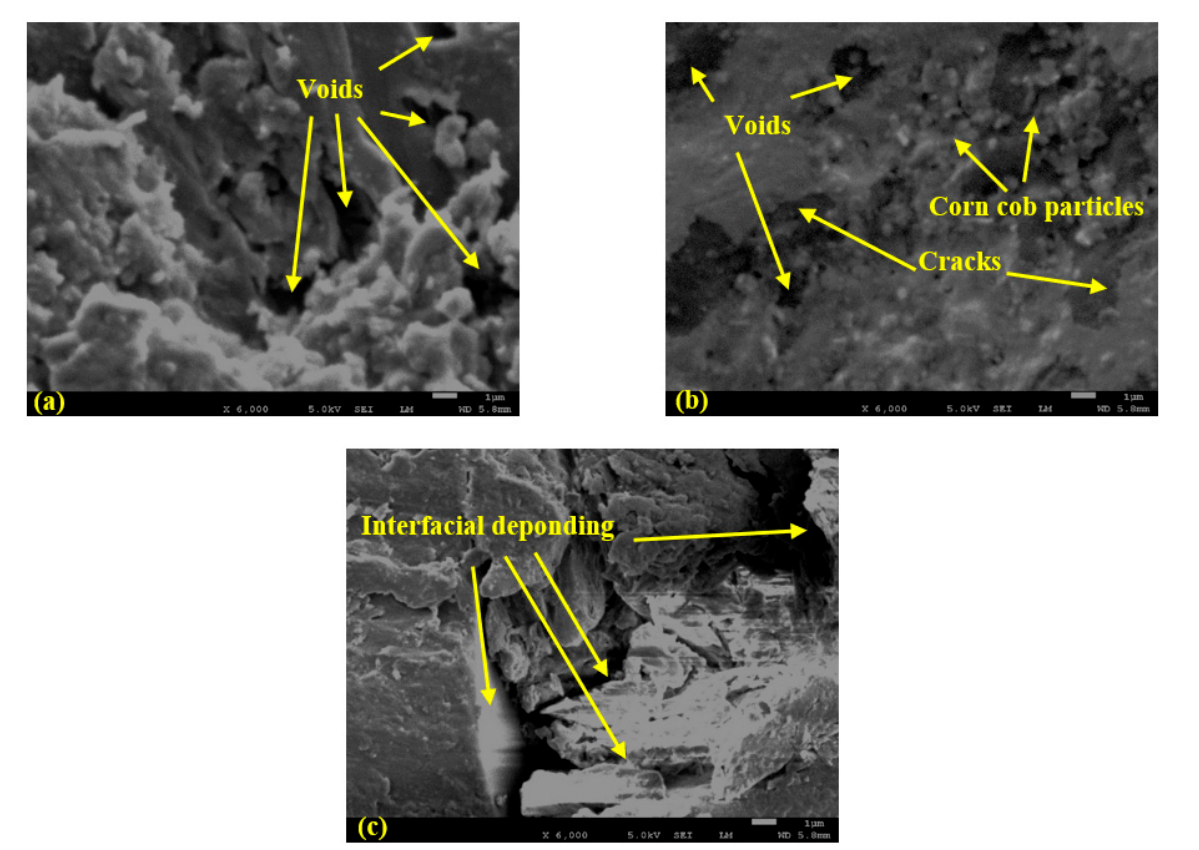
Figure 10. SEM micrographs of the fractographic features of ( a ) PLA, ( b ) PLA-CC10, and ( c ) PLA-CC20.